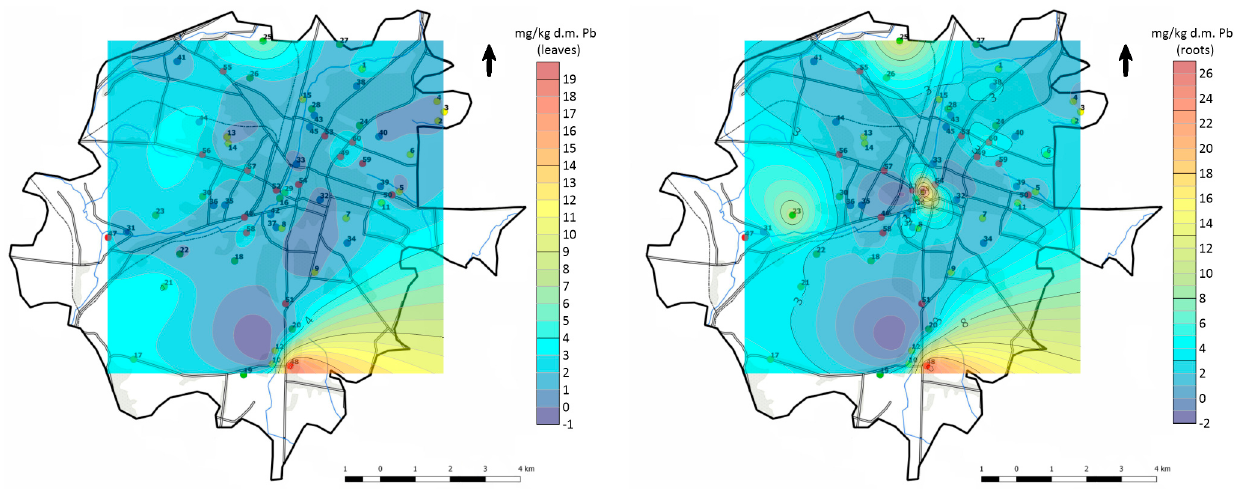
Figure 5. Lead content in the soils and common dandelions from Kielce (kriging method modelling). In Kielce, areas with significantly higher lead concentrations in relation to the back- ground values were identified. Such a situation was recorded for the sample (no. 48) col- lected at the filling station (type D). There, the extreme high values for the common dan- delion’s roots and leaves were also found. Moreover, high lead concentrations in the soils were observed in the samples collected in the areas belonging to the type B–urban forests (no. 23 and 25) and type C–urban green areas (no. 36). The concentrations of lead in the soils correlated with those found in the common dandelion.